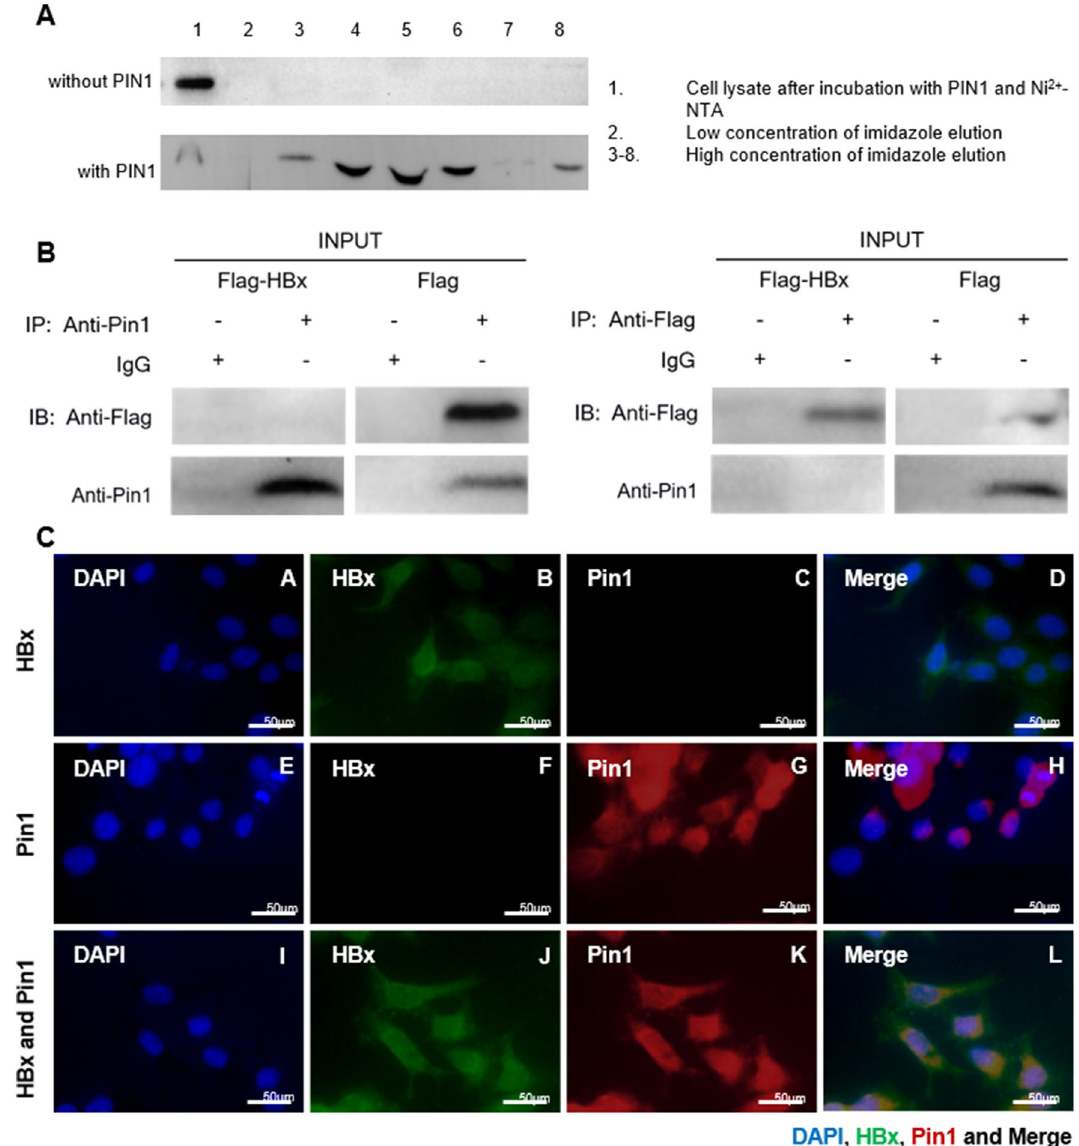
Figure 3. The interaction between HBx and Pin1. Cell lysate of BL21 transfected with Flag-tagged HBx expression plasmids was incubated with Ni2 + -NTA beads adding or not adding purified His 6 -tagged Pin1. HBx was detected in both the whole cell lysate isolated from Ni 2+ -NTA beads and imidazole eluent ( A ). Co-immunoprecipitation assay showed that with the transfection of Flag-tagged HBx, endogenous Pin1 protein pulled down by HBx was detected in eluent after incubated with anti-Flag beads, while HBx was detected in eluent after incubated with anti-Pin1 beads ( B ). Immunofluorescence microscopy shows the common position of Pin1 and HBx in both cytoplasm and nucleus ( C